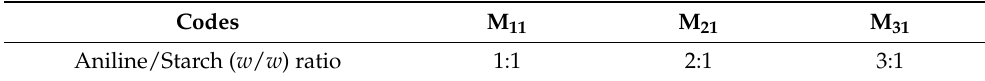
Table 1. Codes of the synthesized